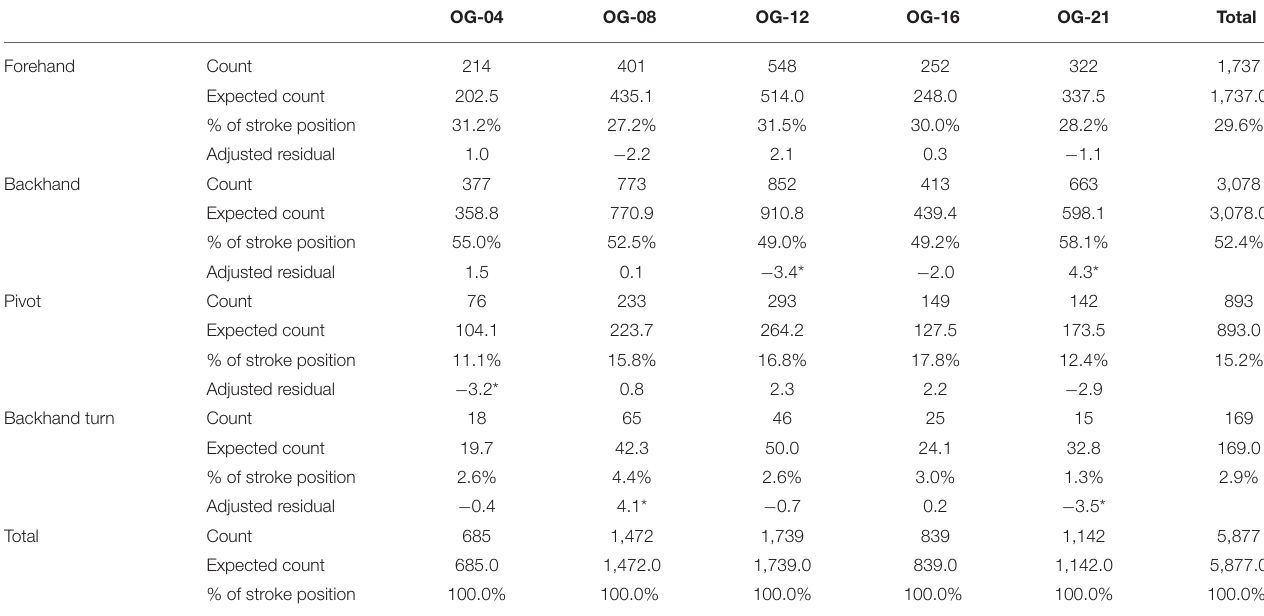
TABLE 1 | The distribution of stroke position throughout the different Olympic Games from 2004 to